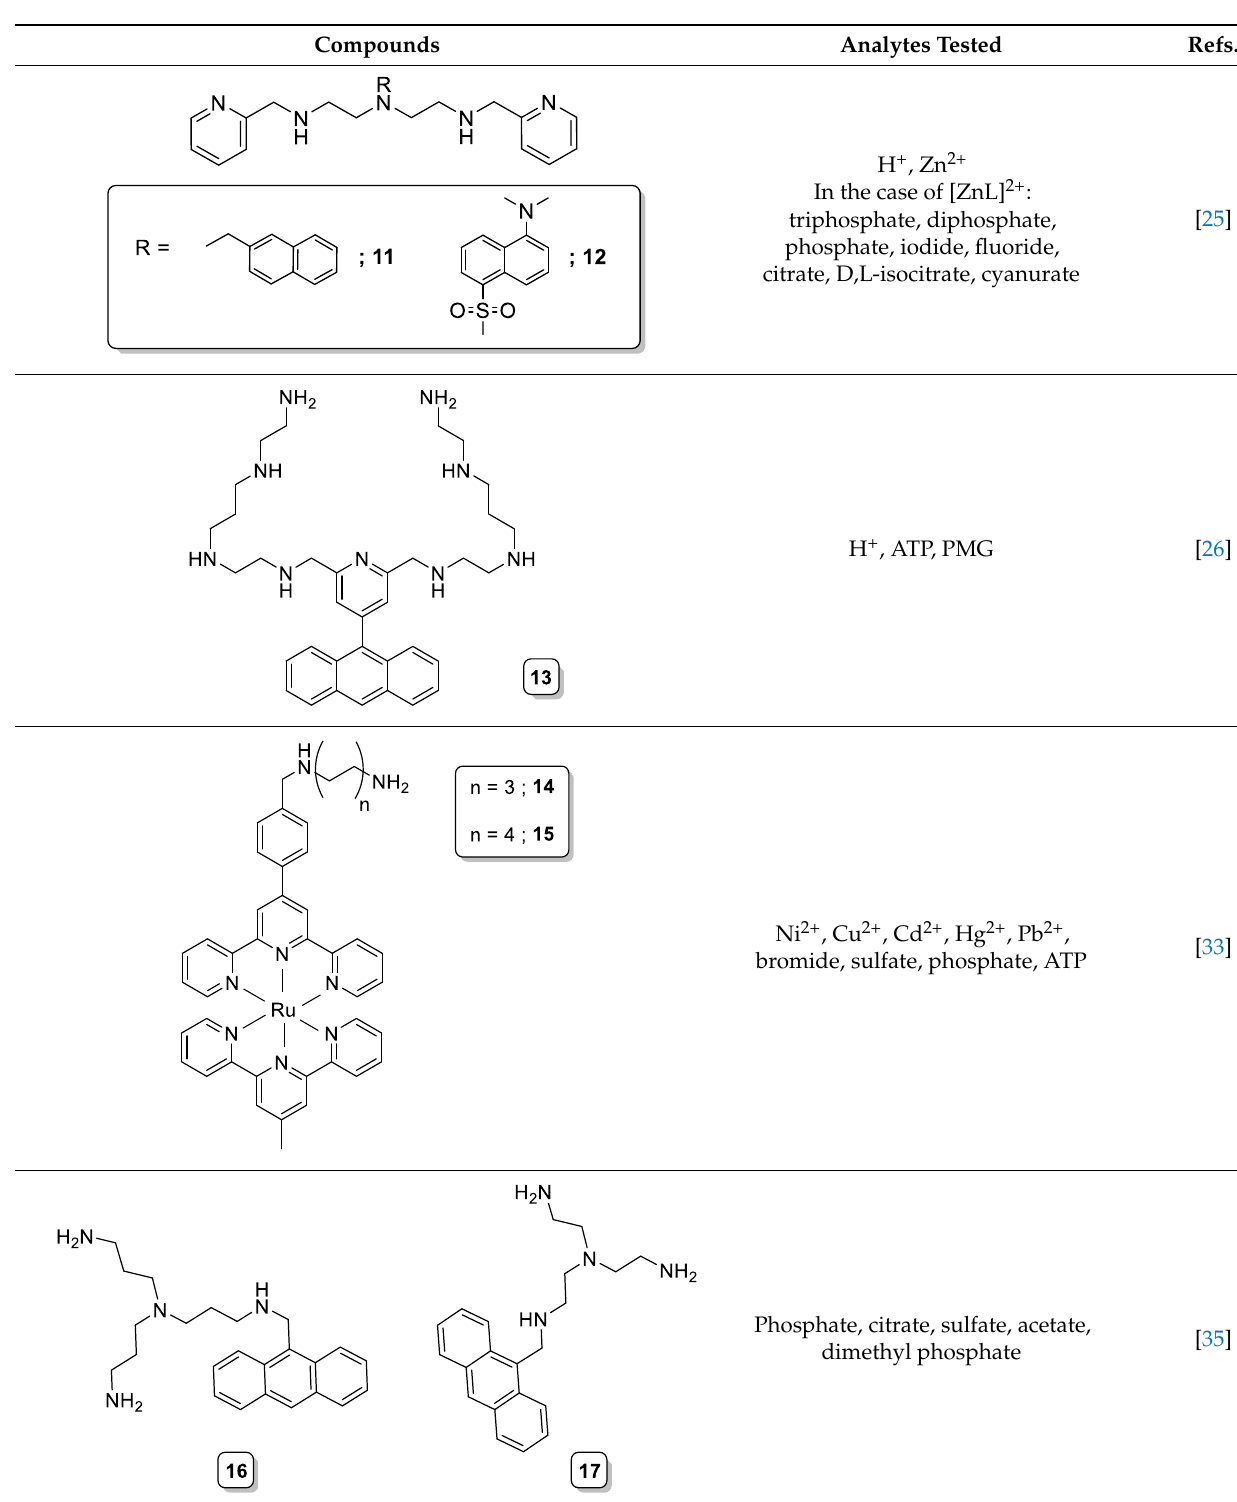
Table A1. Cont. Compounds Analytes Tested